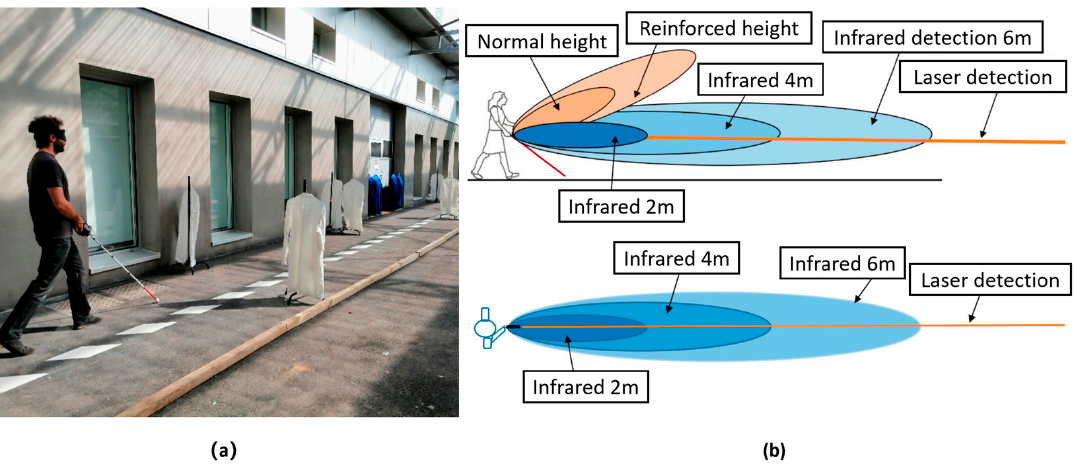
Figure 2. ( a ) A visually impaired holding the Tom Pouce III laser smart cane; ( b ) the detection range of the smart cane [37].